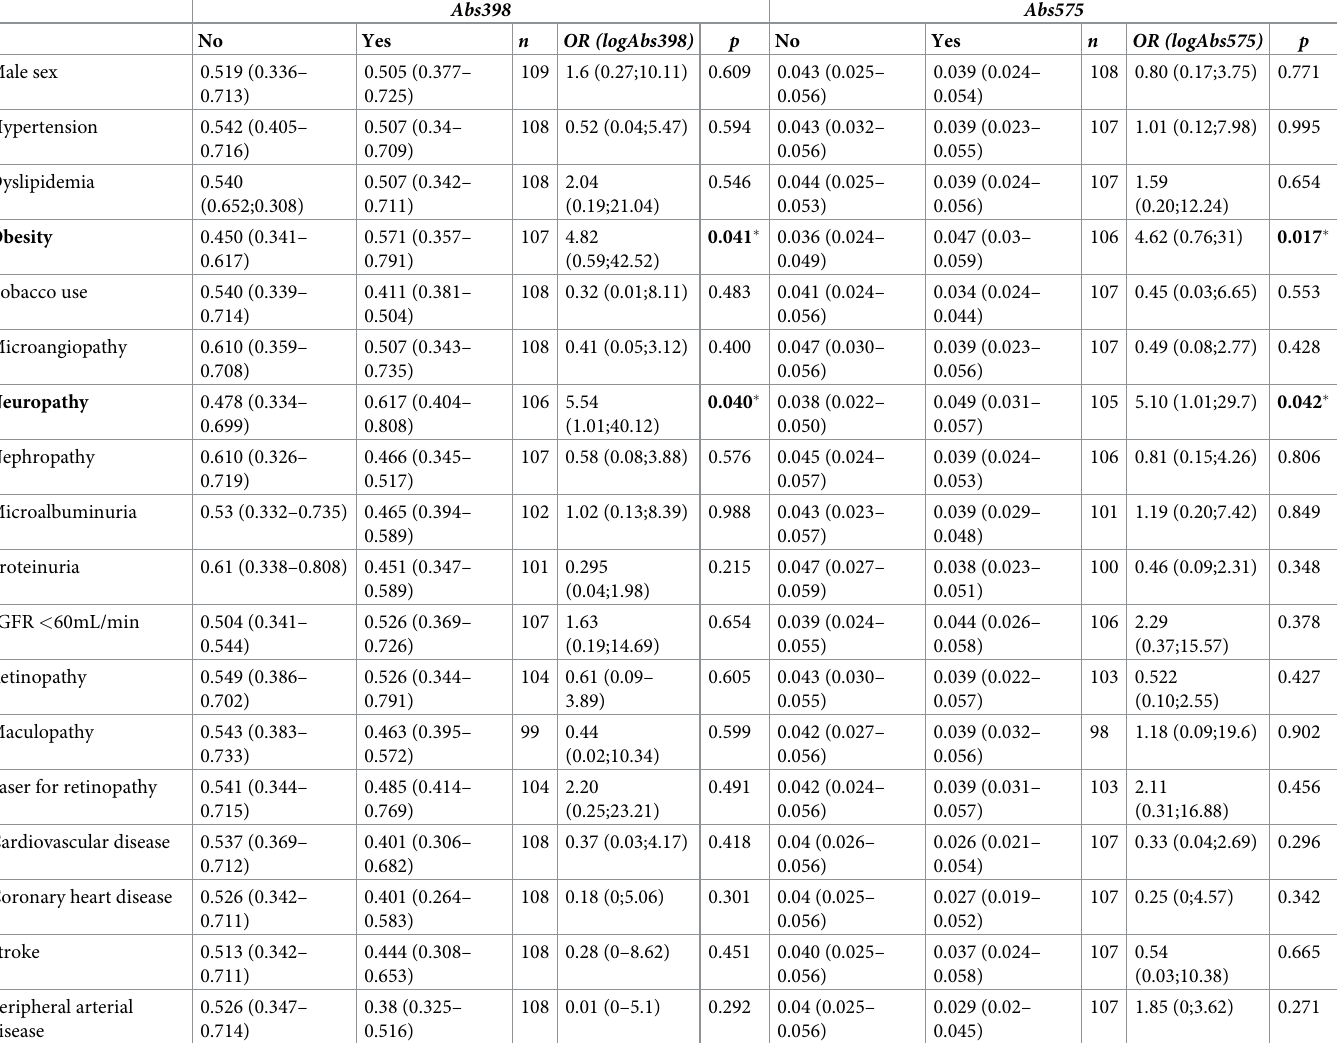
Table 2. Associations between IVH biomarkers and cardiovascular risk factors, or micro- and macrovascular complications in T2D patients: Odds Ratios and their 95% confidence intervals after adjustment for age and